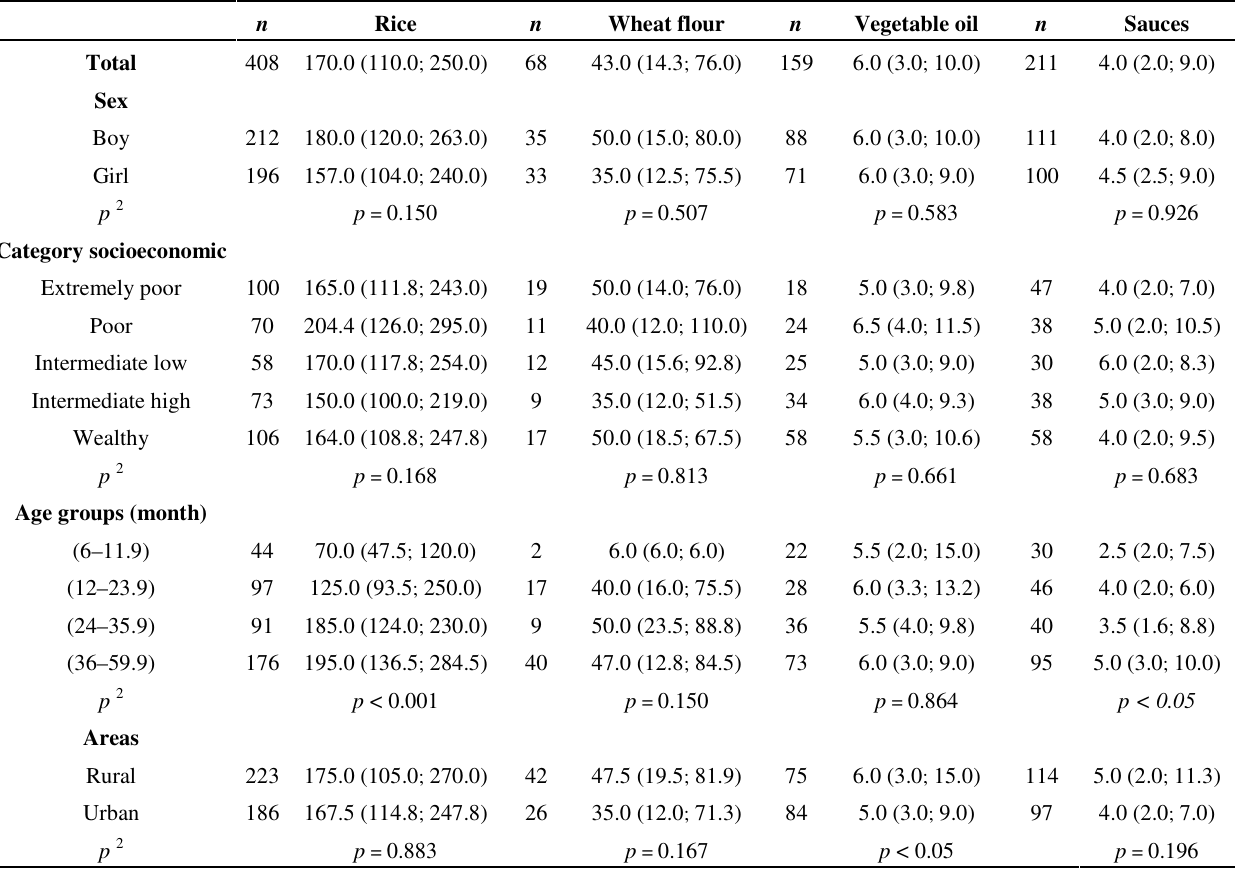
Table 4. Median consumption (25th percentile; 75th percentile) for consumers of selected foods by socioeconomic status, sex, age groups and residence (in g/capita/day) 1 . n Rice